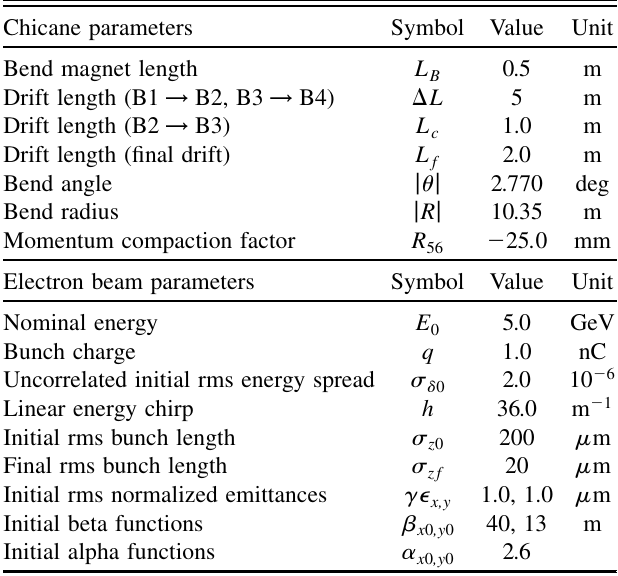
TABLE I. Parameters used for simulation of the Berlin- Zeuthen benchmark chicane [22].